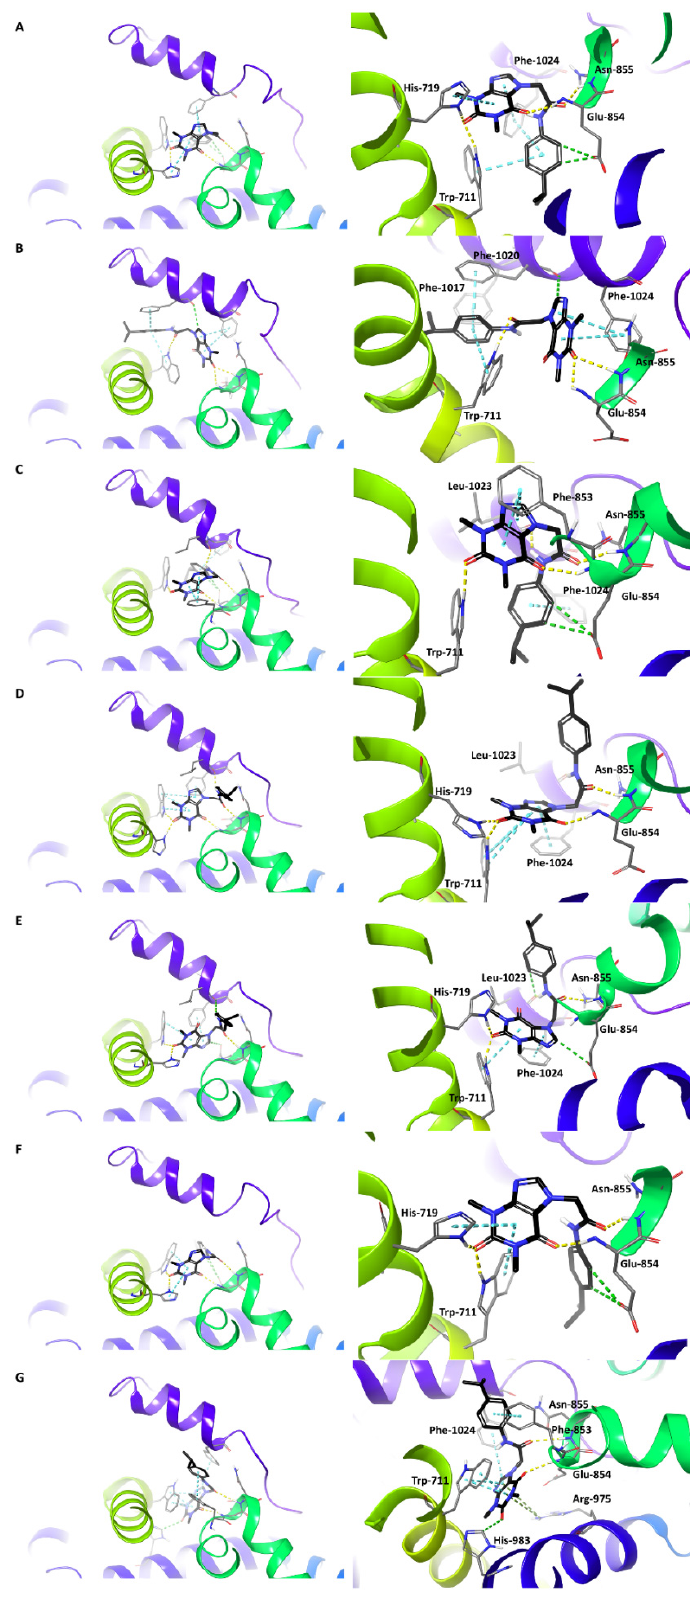
Figure 6. The predicted binding modes of HC-030031 for individual binding site models ( A – G ). View from the top of the channel ( left ) and the detailed illustration of the interactions ( right ), presented as follows: yellow—hydrogen bonds, green—aromatic hydrogen bonds, cyan— π - π stacking, dark green—cation- π interactions.